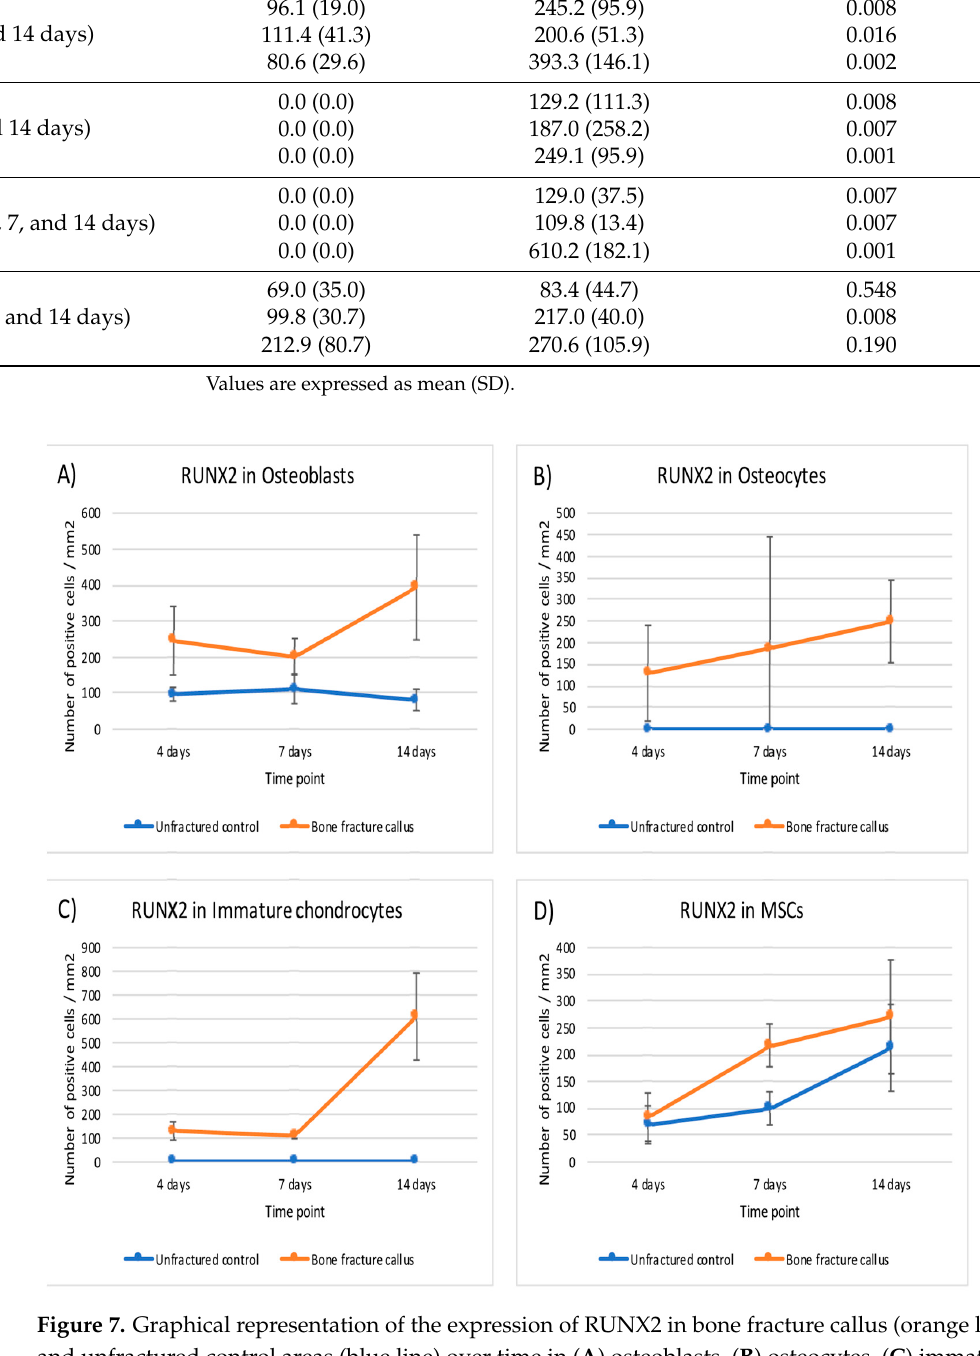
Table 3. Comparison between the expression of RUNX2 in bone fracture callus and unfractured control areas. Expression of RUNX2 (Positive Cells/mm 2 )